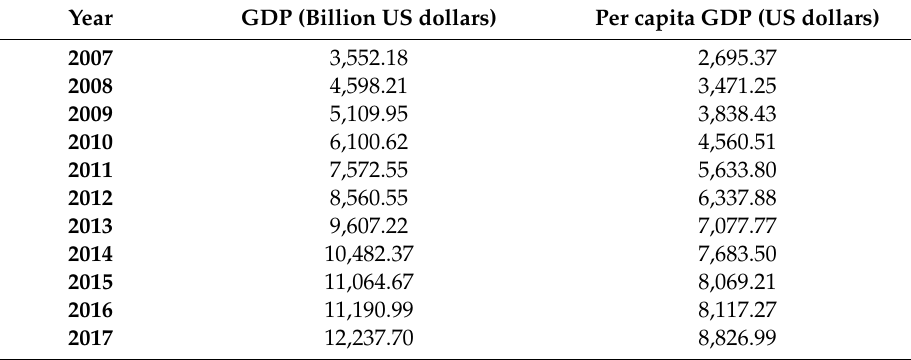
Table A3. China’s total GDP and per capita